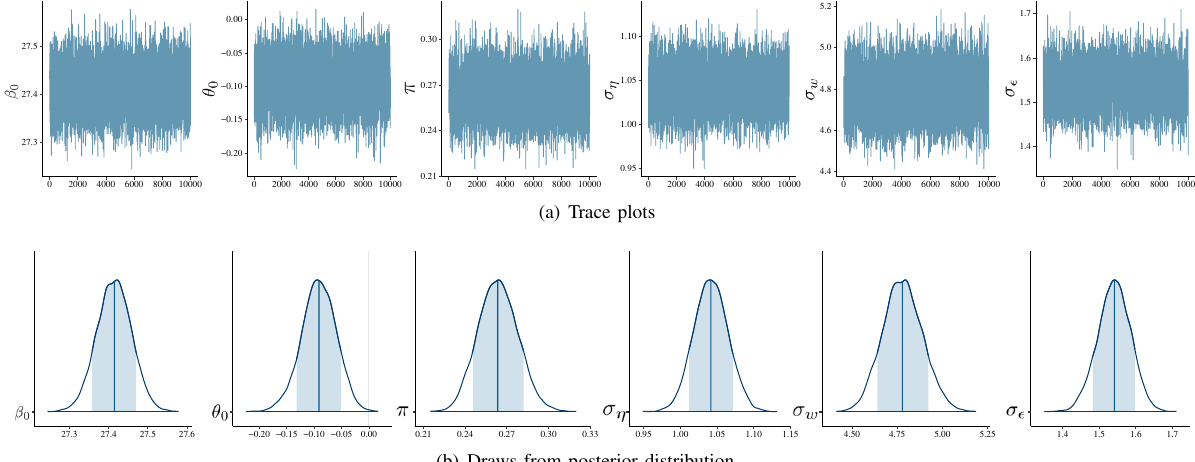
Figure 3. ( a ) Trace plots of Markov chains and ( b ) Markov chain Monte Carlo (MCMC) draws from the posterior distribution of the parameters β 0 , θ 0 , π , σ η , σ w , and σ ǫ based on a sample of length